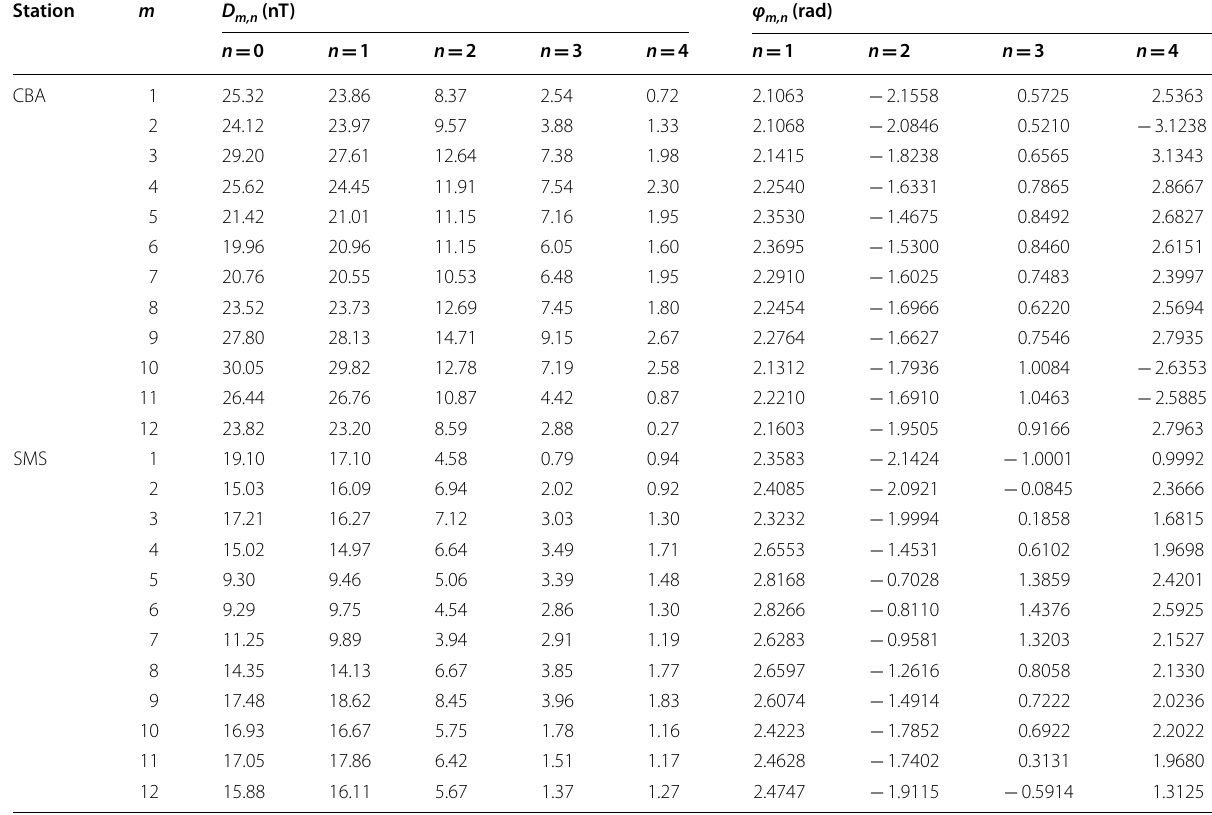
Table 7 Coefficients and phase angles of the daily parameter